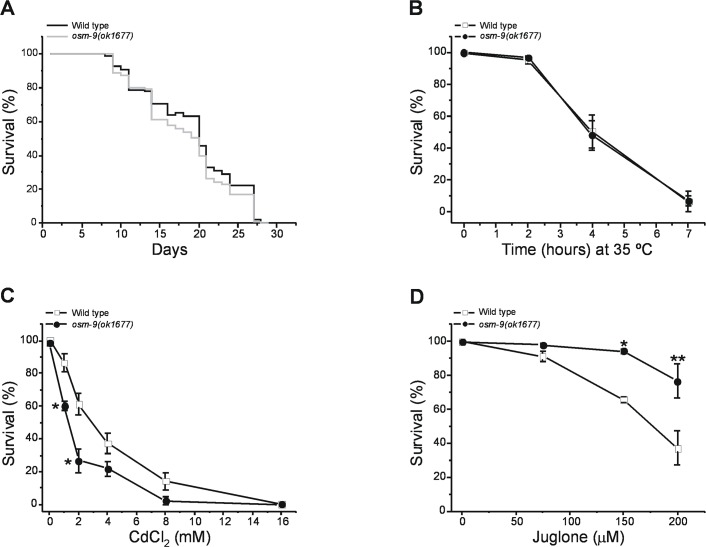
Lifespan and (A) and resistance to heat shock (B), cadmium (C) and oxidative stress (D) in osm-9(ok1677) worms. Median lifespan (A) was 21 days for wild type and osm-9(ok1677) worms (n = 100 worms for both groups). Values in B, C and D are means ± S.E. (n = 5). *P<0.007 and **P<0.04 compared to wild type worms.